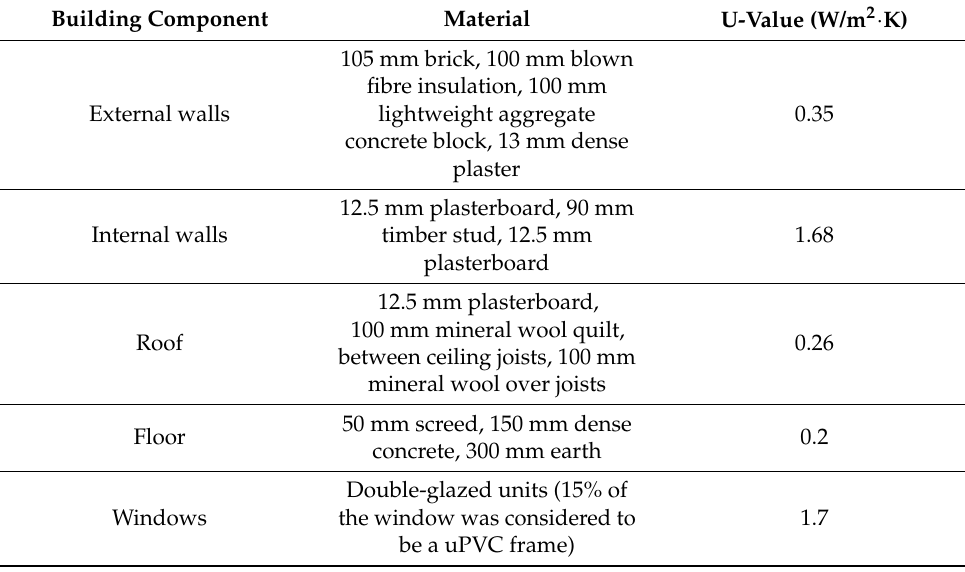
Table 2. Construction materials and thermal properties of the proposed building.